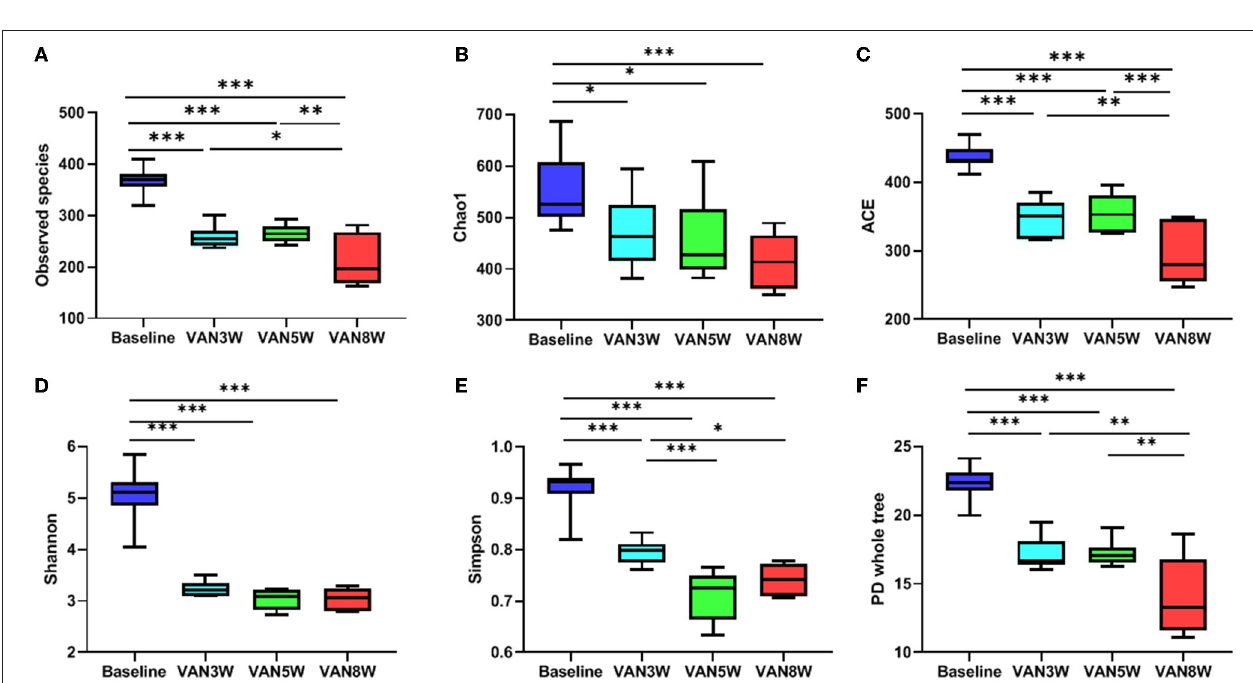
FIGURE 5 | Vancomycin induced change in alpha diversity. Observed species, Chao 1, ACE, Shannon, Simpson, and PD whole tree indexes were shown in (A–F) , respectively. Significant differences between the two groups were marked, and * p < 0.05; ** p < 0.01, and *** p < 0.001. VAN, vancomycin.